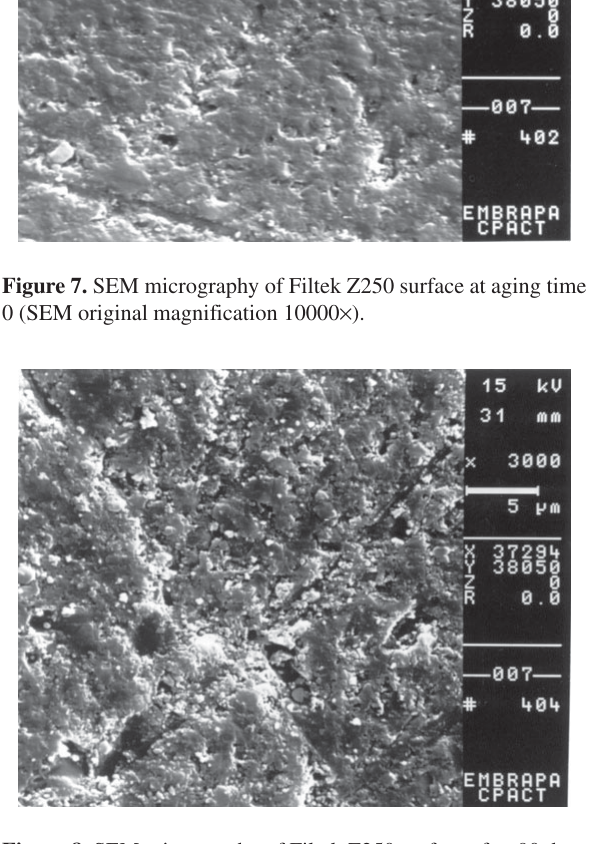
Figure 6. SEM micrography of Belleglass surface after 90 days of aging (SEM original magnification 10000 × ).